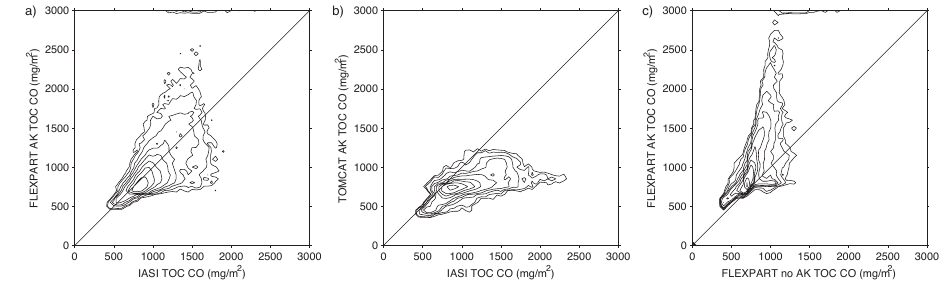
Fig. 8. (a) Probability density distribution of AK weighted FLEXPART simulation vs. IASI retrievals, (b) AK weighted TOMCAT simulation vs. IASI retrievals, (c) AK weighted FLEXPART simulation vs. FLEXPART simulation without AK weighting. Contour intervals are ( 1 , 2 , 5 ) × 10 − 4 ,( 1 , 2 , 5 ) × 10 − 3 ,( 1 , 2 , 5 ) × 10 − 2 , 1 × 10 − 1 .